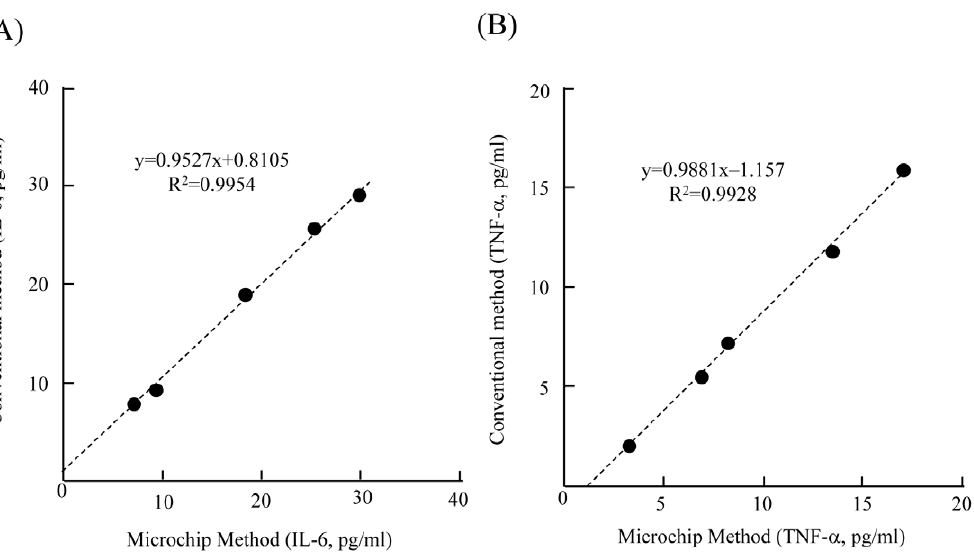
Figure 4. Comparative analysis of the values obtained with the microchip method and the conventional microtitration plate method. Linear regression analysis was used. (A) IL-6 (B) TNF- a .